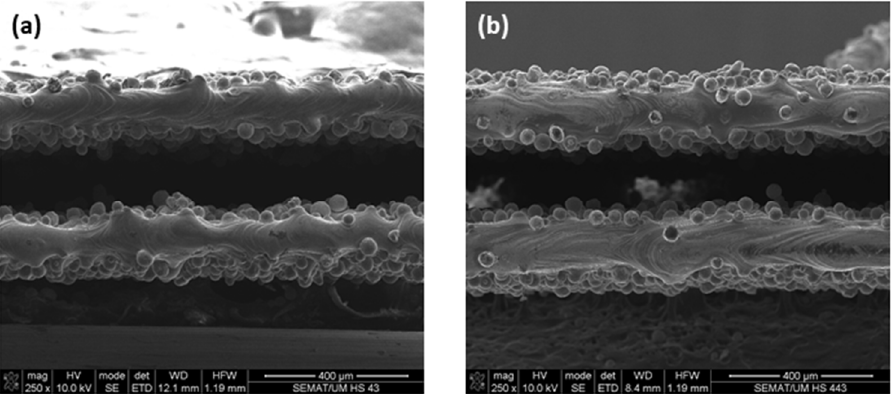
Figure 11. Central part image of thin-walled tubes built in experiment numbers ( a ) 2 (50 W/400 400 mm/s) and ( b ) 18 (100 W/400 mm/s). mm/s) and ( b ) 18 (100 W/400 mm/s).